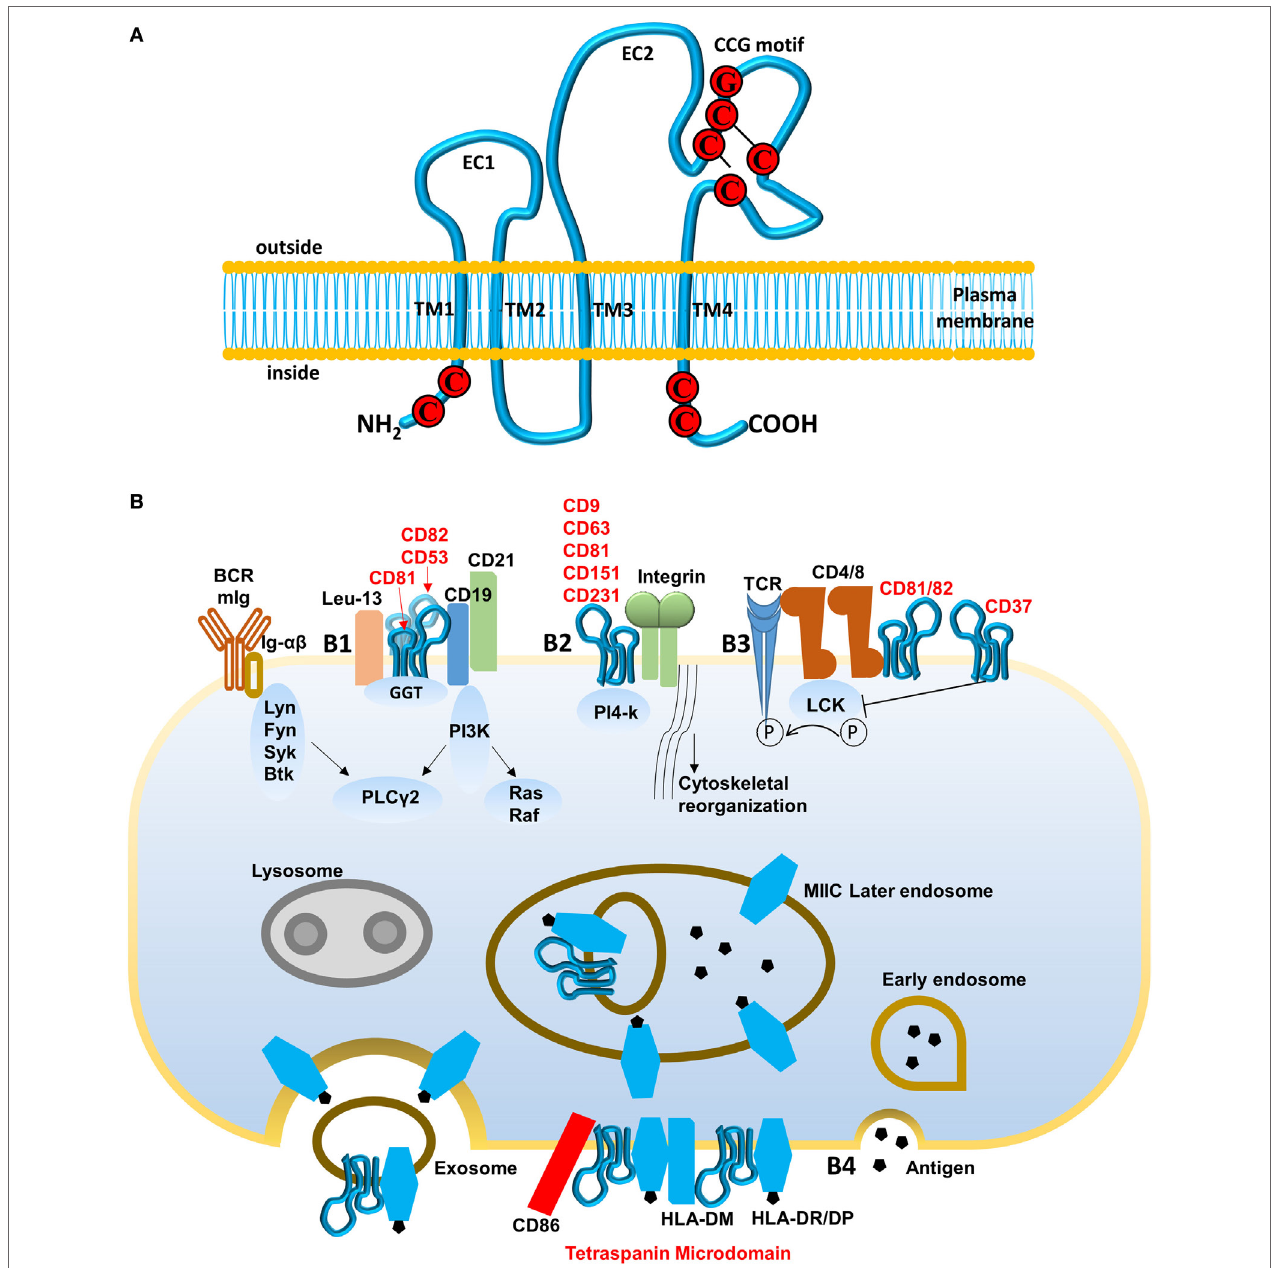
FiGURe 3 | Structure of tetraspanin and pathways regulated by tetraspanins. (A) Schematic diagram of tetraspanins. Tetraspanins present four transmembrane domains (TMs) intracellular N- and C-termini and two extracellular domains (EC1 and EC2). CCG motif is formed with cysteine–cysteine–glycine (marked by red) and two disulfide bonds (marked by black line). (B) Pathways regulated by tetraspanins. (B1) B cell receptor (BCR) activation mediated by CD19–CD81–CD21 complex. Ig- α / β receive signals and are phosphorylated by Src kinase (Lyn, Fyn, or Btk), then recruit Syk kinase for initiating downstream signal pathway PLC γ 2, Ras/Raf. Tetraspanin CD81, associated with CD52 and CD82, binds C19/CD21/Leu-13 signal-transducing complex and actives PLC γ 2 through PI3K, which lowers the threshold for BCR signaling. (B2) Integrin-mediated cell adhesion. PI4-k, associated with various tetraspanins (CD9, CD63, CD81, CD151, and CD231), interacts with and promotes integrins to modulate cell spread and migration. (B3) T cell-B cell contact (TCR) pathway mediated by tetraspanins CD81, CD82, and CD37. CD4 and CD8 associate with Lck kinase to activate TCR signaling but their interaction with CD81, CD82, and CD37 interferes with phosphorylation of Lck kinase and may inhibit TCR signaling. (B4) Endocytic pathway for antigen presentation. Recognized antigens are internalized, processed, and loaded onto MHC class II molecules during the late endosome stage. Major histocompatibility complex class II mediates transport to the cell surface and the release of exosomes. Tetraspanin microdomains in antigen-presenting cell membranes are enriched for specific peptide–MHC class II complexes, peptide editor human leukocyte antigen-DM, and CD86 among other proteins. This selecting domain probably facilitates antigen presentation and T-cell activation, increasing MHC avidity.